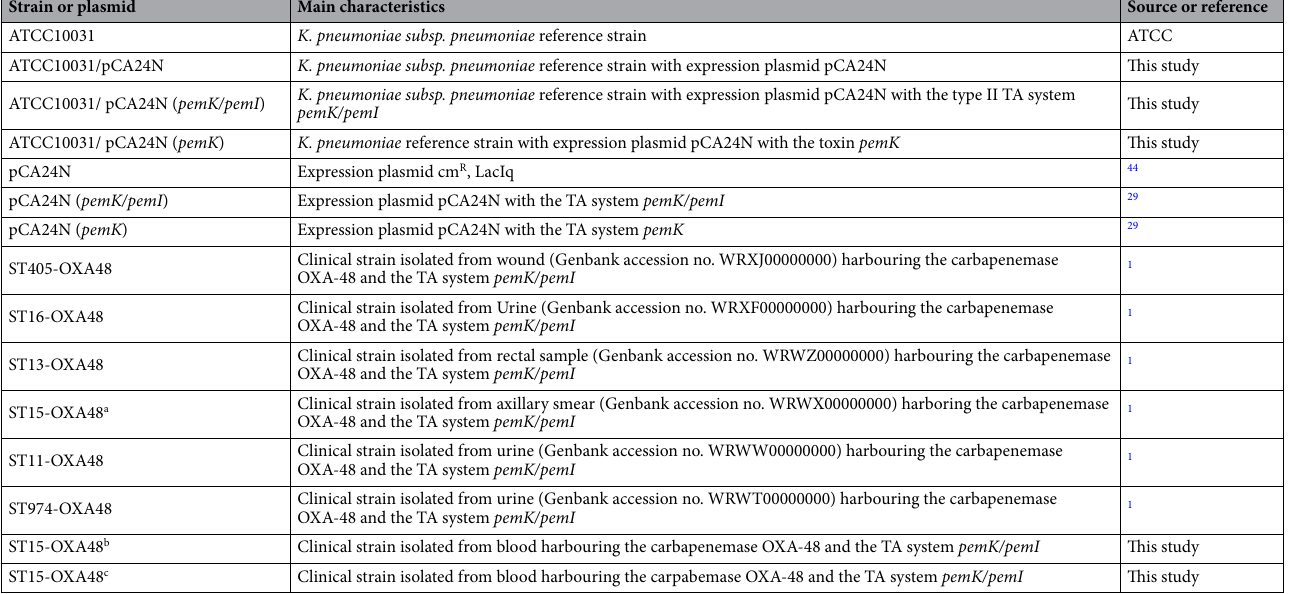
Table 3. Bacterial strains and plasmids used in this